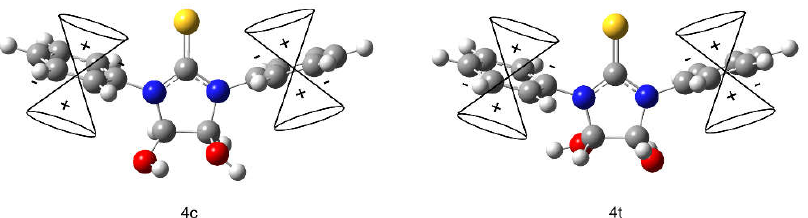
Figure 9. Location of anisotropy cone of phenyl rings in structures of cis- 4c and trans- 4t 4,5-dihydroxy-1,3-diphenylimidazolidine-2-thione.